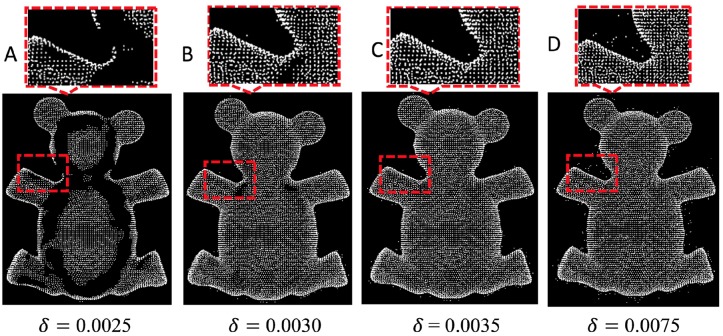
Different δ in our method.